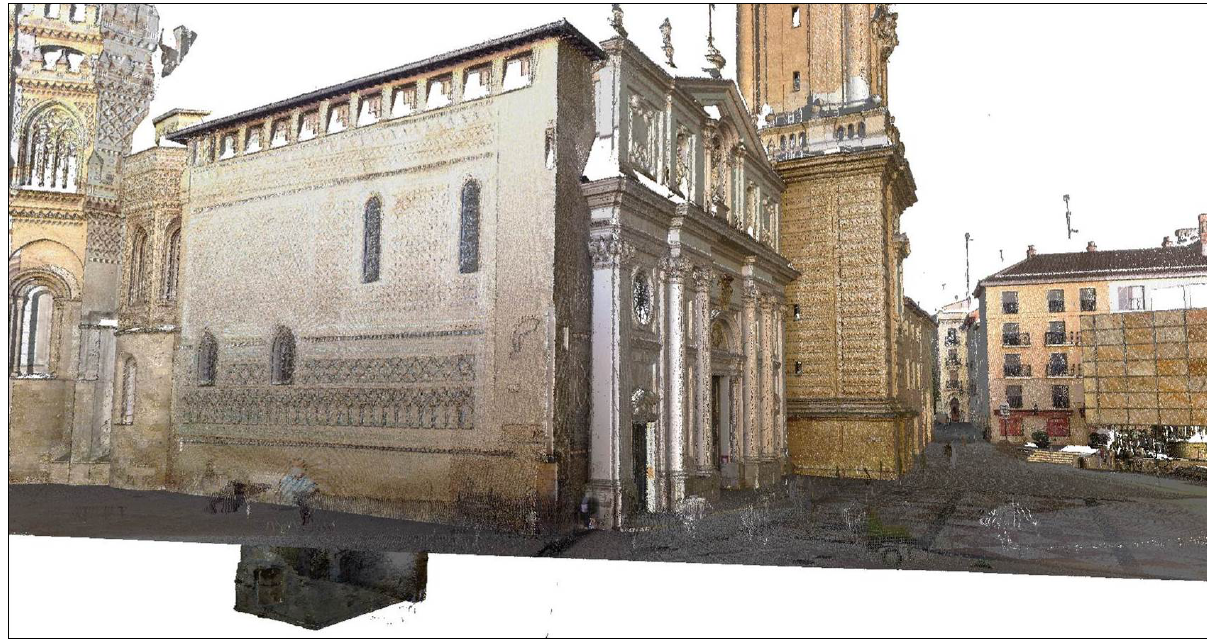
Figure 5 . External view of the Chapel of San Miguel.